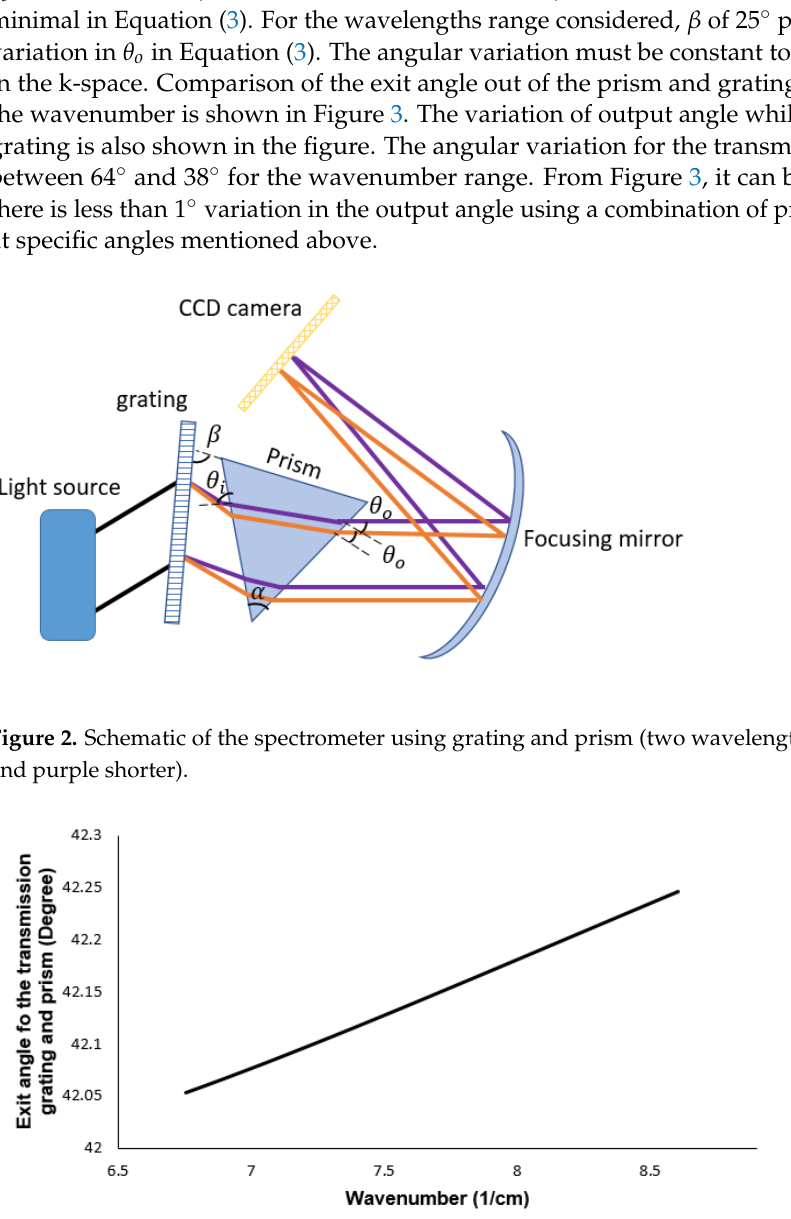
Figure 3. The variation of the exit angle for different wavenumbers for combination of transmission grating and